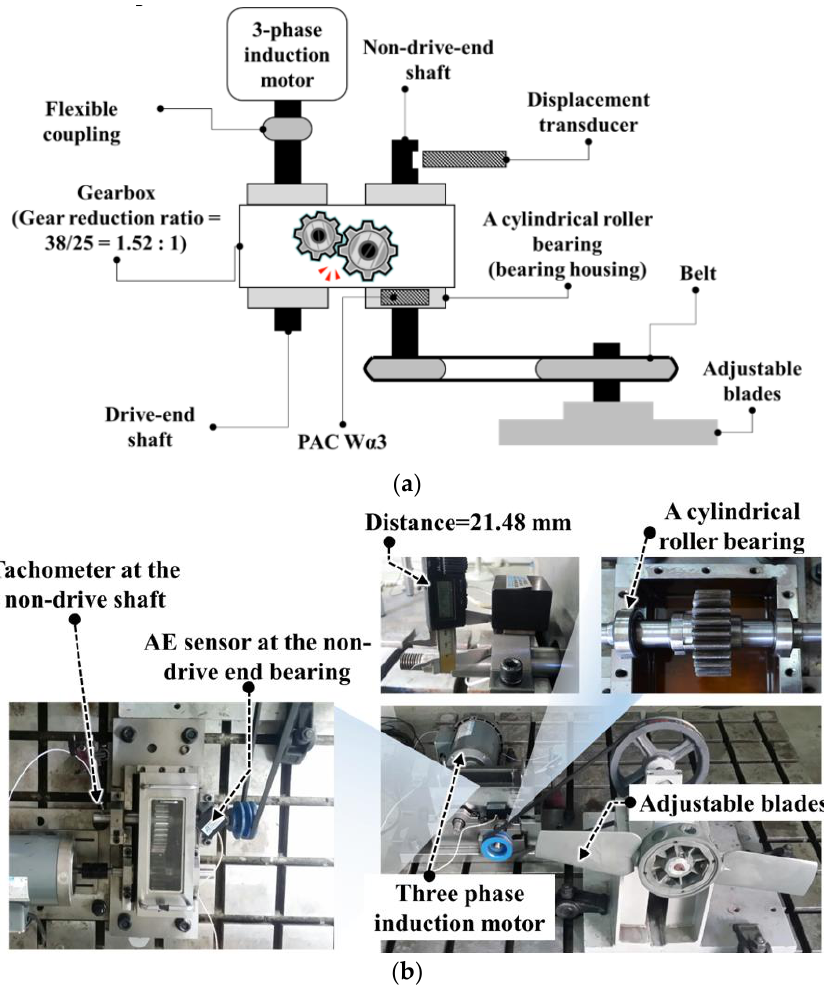
Figure 7. The illustration of the bearing fault simulator: ( a ) the diagram of the bearing fault simulator and ( b ) the photographs of the bearing fault simulator.